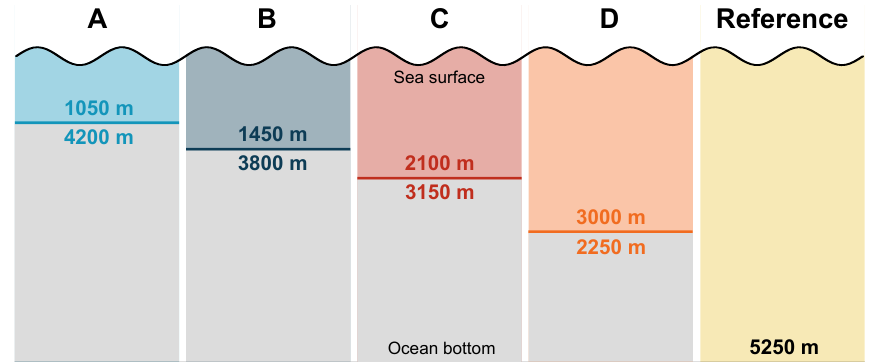
Figure 2. Vertical two-layer partition of the oceanic electric current source in scenarios A to D. Values around the separation lines are upper and lower layer thicknesses. Oceanic electric currents in the grey-shaded lower layers are excluded in the scenarios A to D. The reference includes oceanic electric currents from the entire water column.